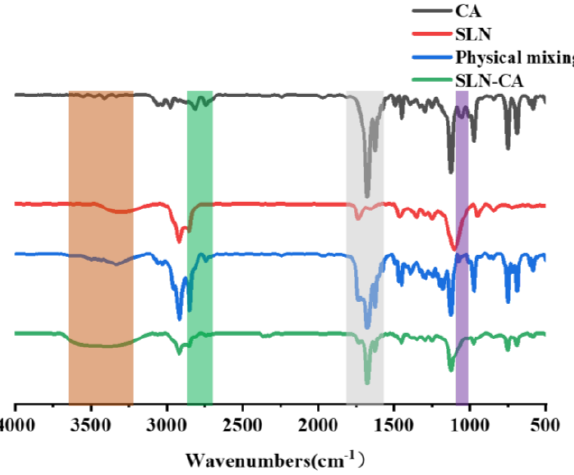
Figure 8. CA, SLN, physical mixture, FT-IR spectrum of SLN-CA.